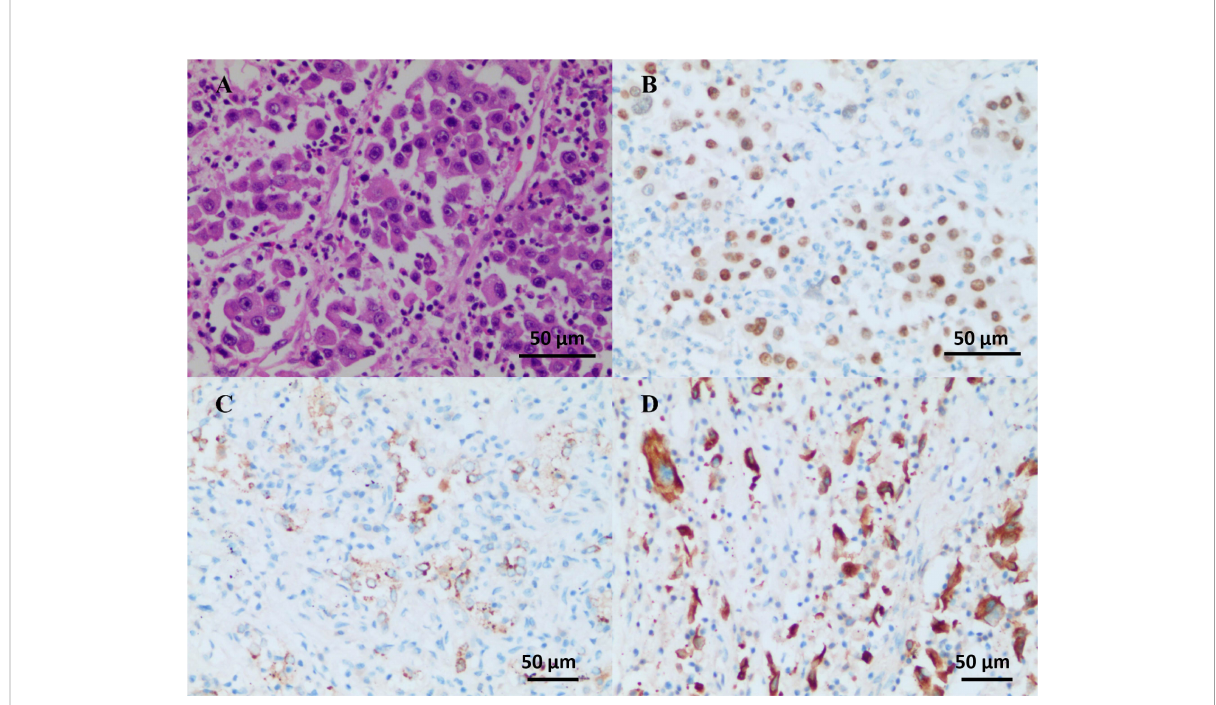
FIGURE 3 Operative and pathological fi ndings. The pathological diagnosis was poorly differentiated lung adenocarcinoma (solid type) with the size of 2.2 cm × 2.0 cm × 1.2 cm, and the visceral pleura was not involved. No in fi ltration of cancer cells was detected in the bronchus cutting edges. Pulmonary hilar lymph node (-, 0/5). Immunohistochemistry outcomes were presented as: HE (A) , TTF-1 (+) (B) , NapsinA (+) (C) , CK7 (+) (D) , CK5/6 (-), CK (pan) (+), and Ki-67 (+, about